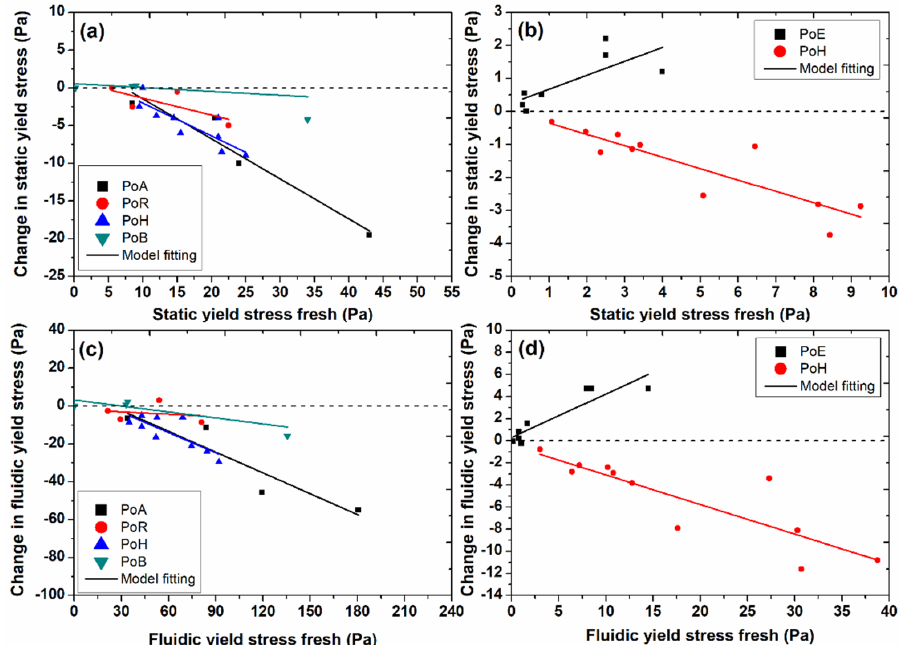
Figure 2. Change in static yield stress (degraded–fresh) as a function of static yield stress of fresh mud samples ( a ) from different ports and ( b ) from PoE and fluid mud samples from PoH; ( b ) change in fluidic yield stress (degraded–fresh) as a function of fluidic yield stress of fresh mud samples ( c ) from different ports and ( d ) from PoE and fluid mud samples from PoH. The dashed line represents the value where the degraded and fresh mud samples have the same yield stresses. The solid line represents the empirical fitting using Equation